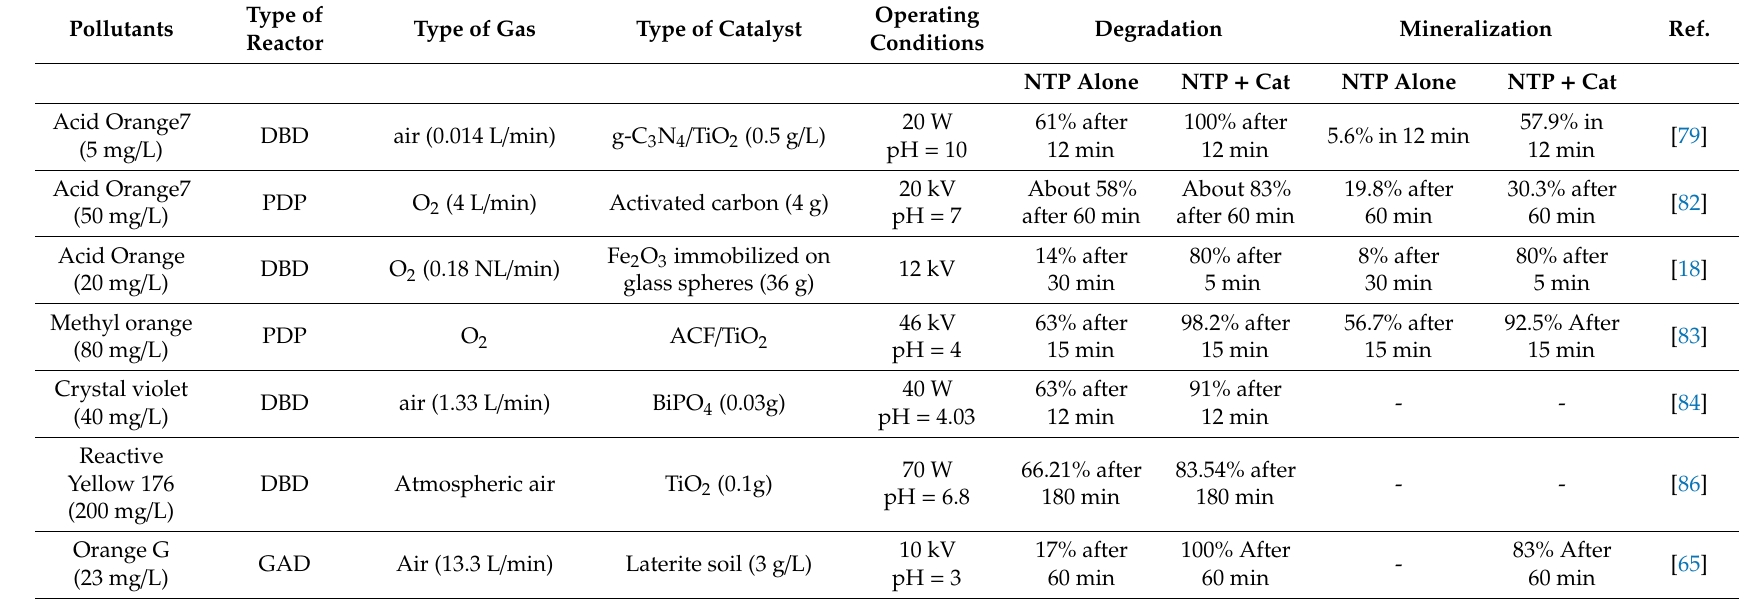
Table 2. Summary of the main operating condition and catalyst used for the degradation and mineralization of dyes in aqueous phase by NTP coupled with